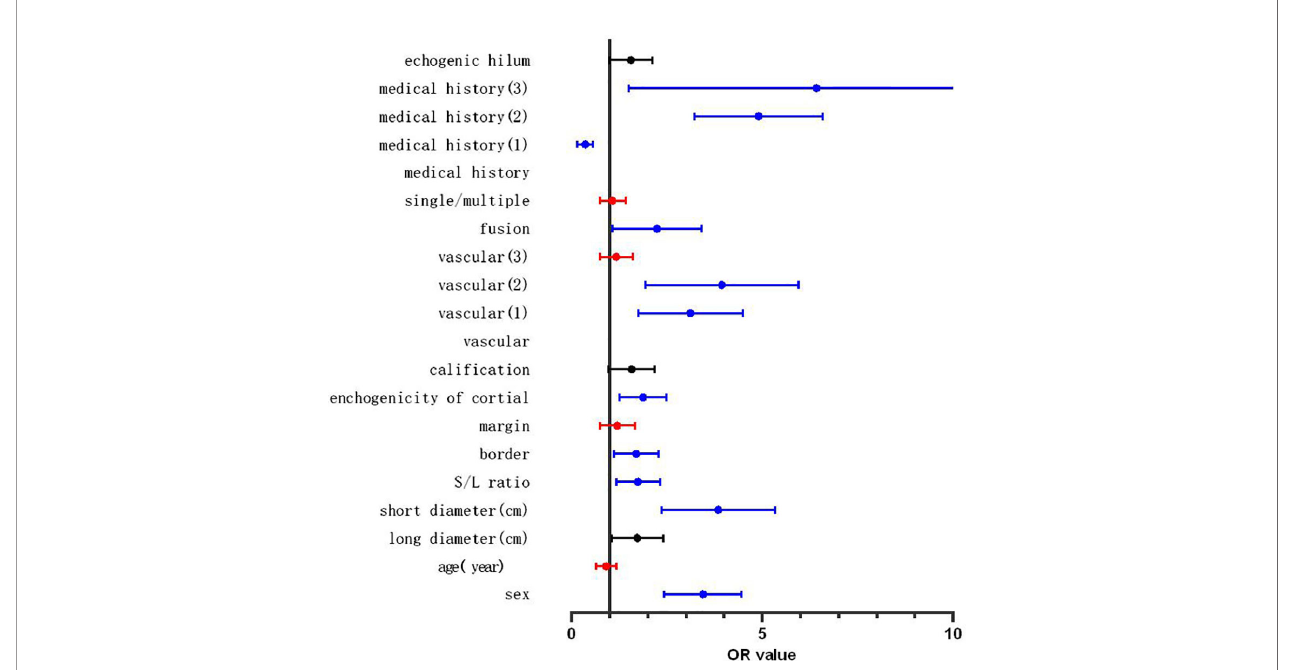
FIGURE 2 | Forest map of the results of binary logistic regression. Red line: the variables with no independent predictive power ( p > 0.05), blue line: the variables showing signi fi cant independent predictive power ( p < 0.01), black line: the variables showing a certain independent predictive power (0.05 > p > 0.01).